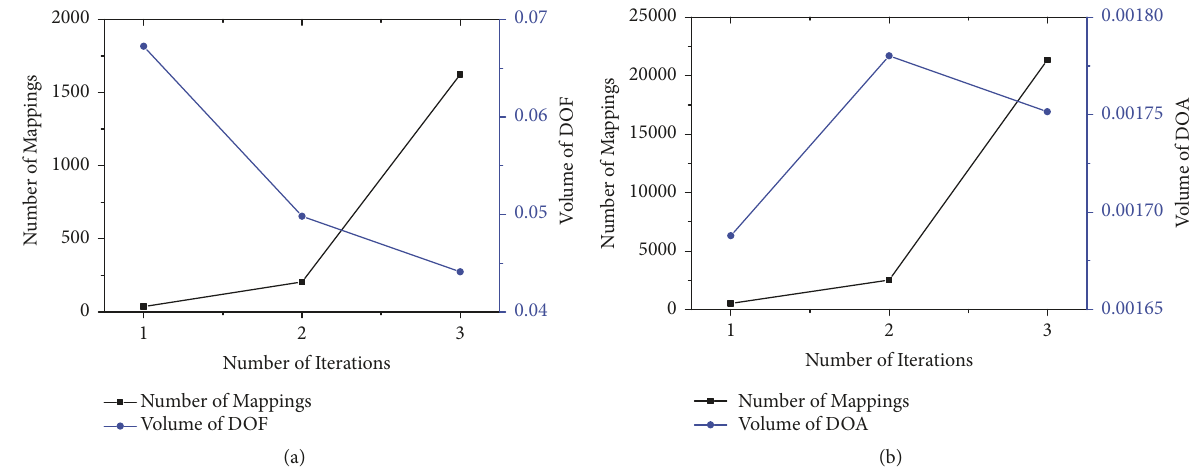
Figure 5: The number of mappings and the volume of domain at each iteration. (a) The curves of the cell deletion procedure; (b) the curves of the cell refinement